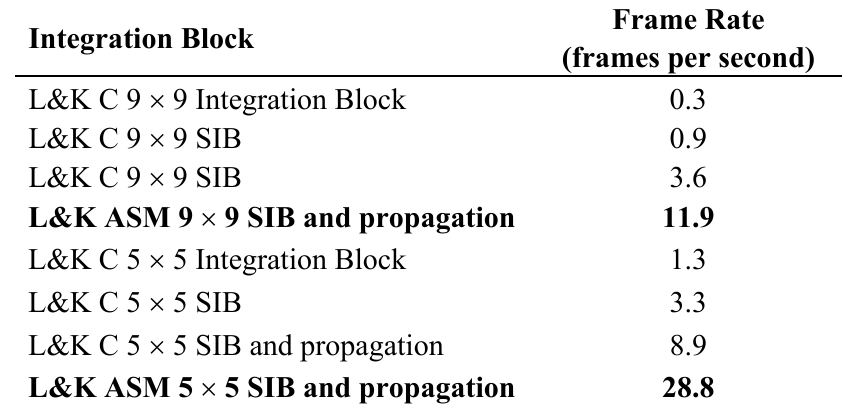
Table 1. System performance evaluation obtained with a 176 × 144 spatial